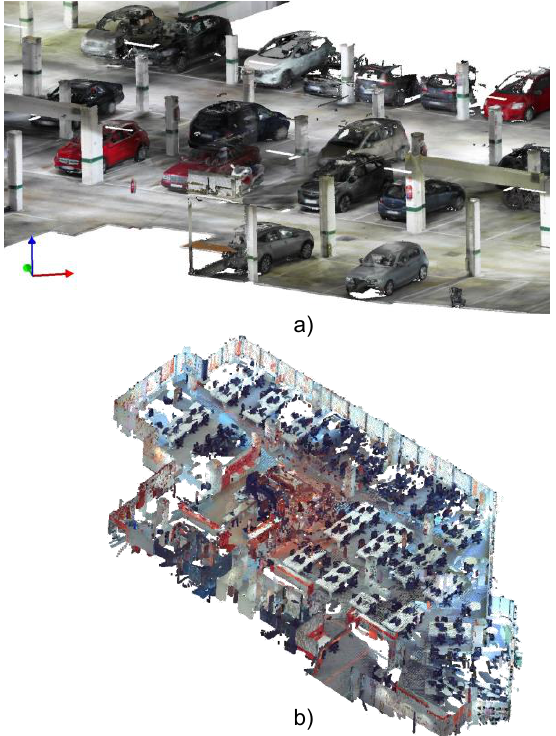
Figure 1. Samples point cloud of the car park (a) and the office space (b).